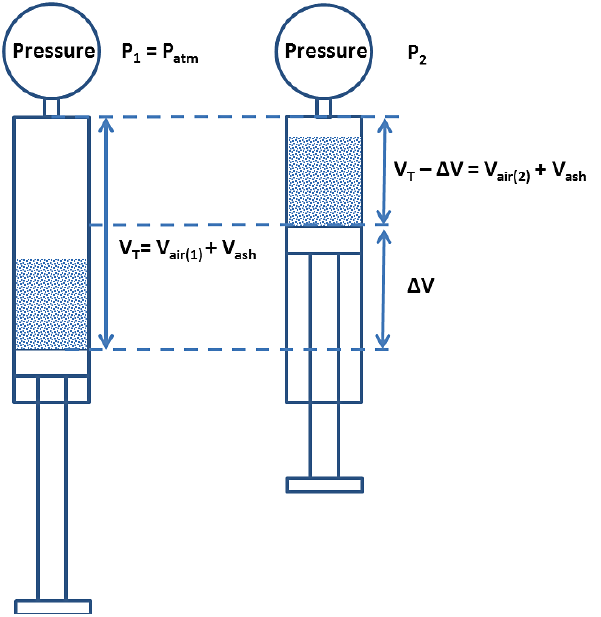
Figure 5. Schematic drawing of the experimental procedure for de- termination of the grain density of the volcanic ash.